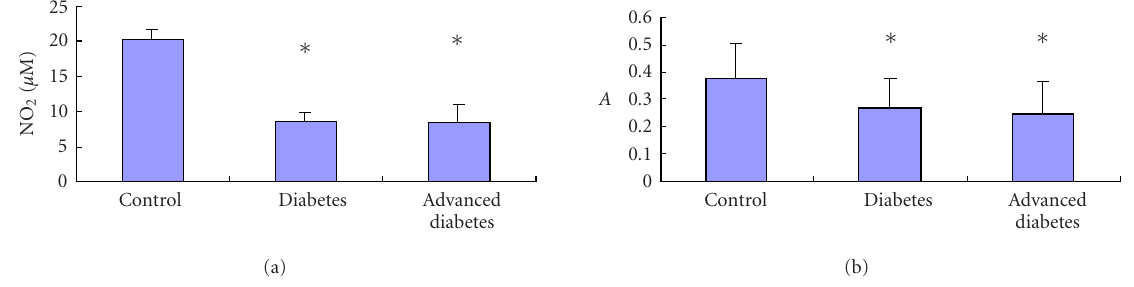
Figure 4. Defective phagocytic activity in diabetic mice is shown. Peritoneal Mp were harvested from the abdominal cavities of mice injected 72 hours earlier with liquid para ffi n, the cells were adjusted to 5 × 10 6 cells/mL per well, and the ability of uptaking neutral fuchsin is indicated by A value at 570